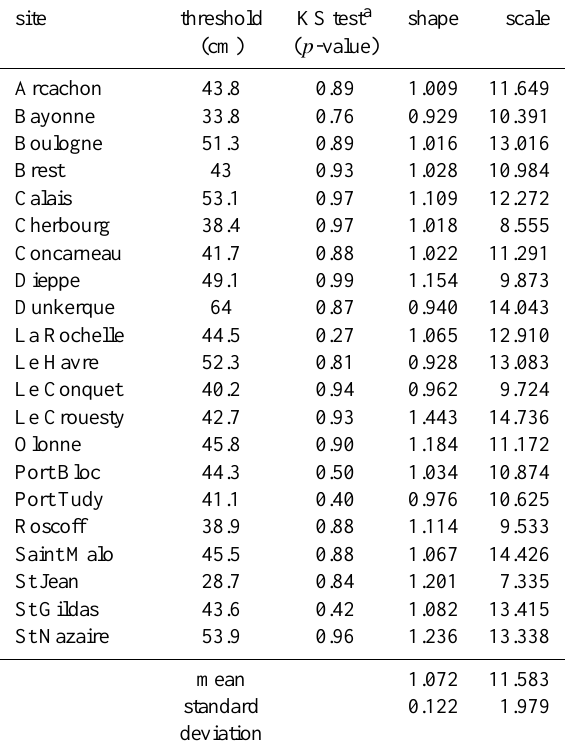
Table 2. Shape factors, scale factors, and Kolmogorov-Smirnov tests of the at-site distributions (Weibull) for thresholds correspond- ing to three events a year in average.